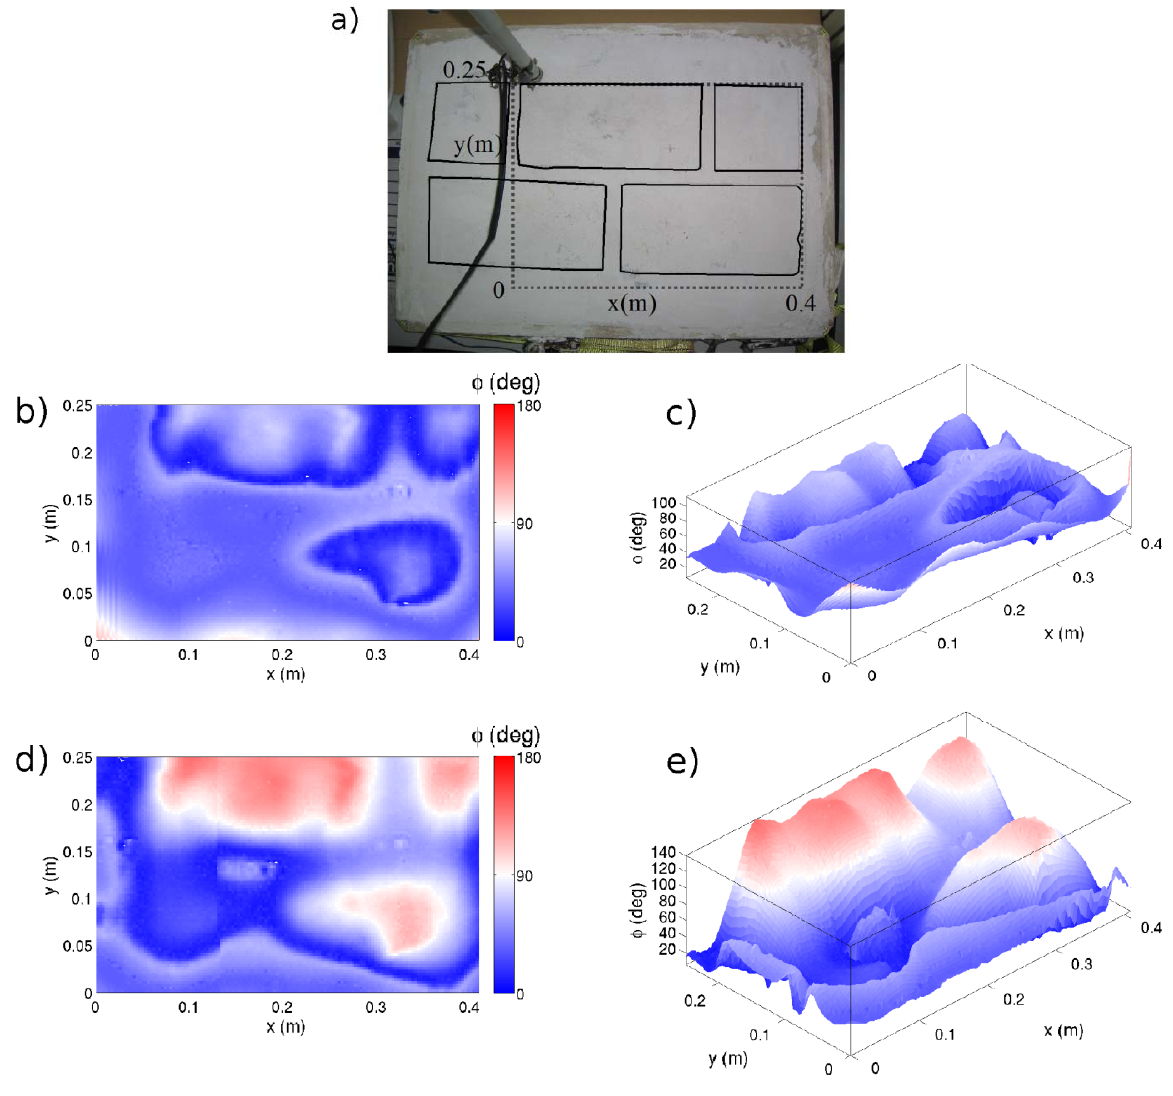
Figure 6. Obtained results: ( a ) Image of the test specimen, where the dashed line marks the scanned area and the continues line depicts the limits of the bricks; ( b ) Two-dimensional representation of phase values measured at h = 1 mm; ( c ) Same results as in (b) represented three-dimensionally; ( d ) Two-dimensional representation of phase values measured at h = 2 mm; ( e ) Same results as in (d) represented